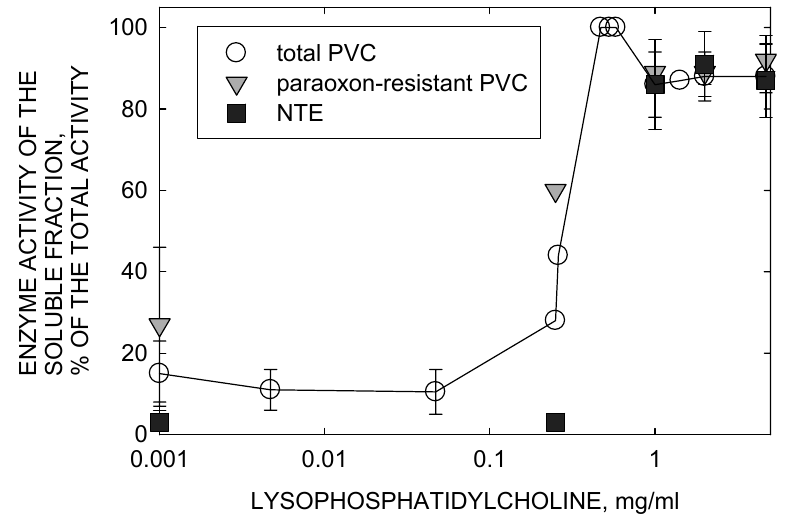
FIGURE 2. Solubilization of NTE and other PVCs from chicken embryo BMF by L- α - lysophosphatidylcholine. Enzyme activities are the arithmetic averages of triplicate assays with an error bar for the standard deviation where at least three independent experiments were carried out. 100% activities of the total PVCs, paraoxon-resistant PVCs, and NTE were 450 ± 156, 297 ± 123, and 172 ± 134 pmoles.min –1 .[mg wet brain] –1 ,